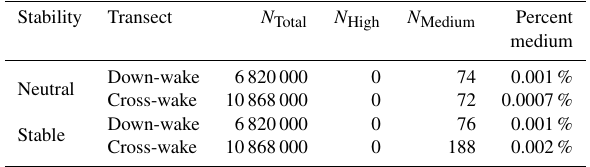
Table 1. Summary of roll hazards